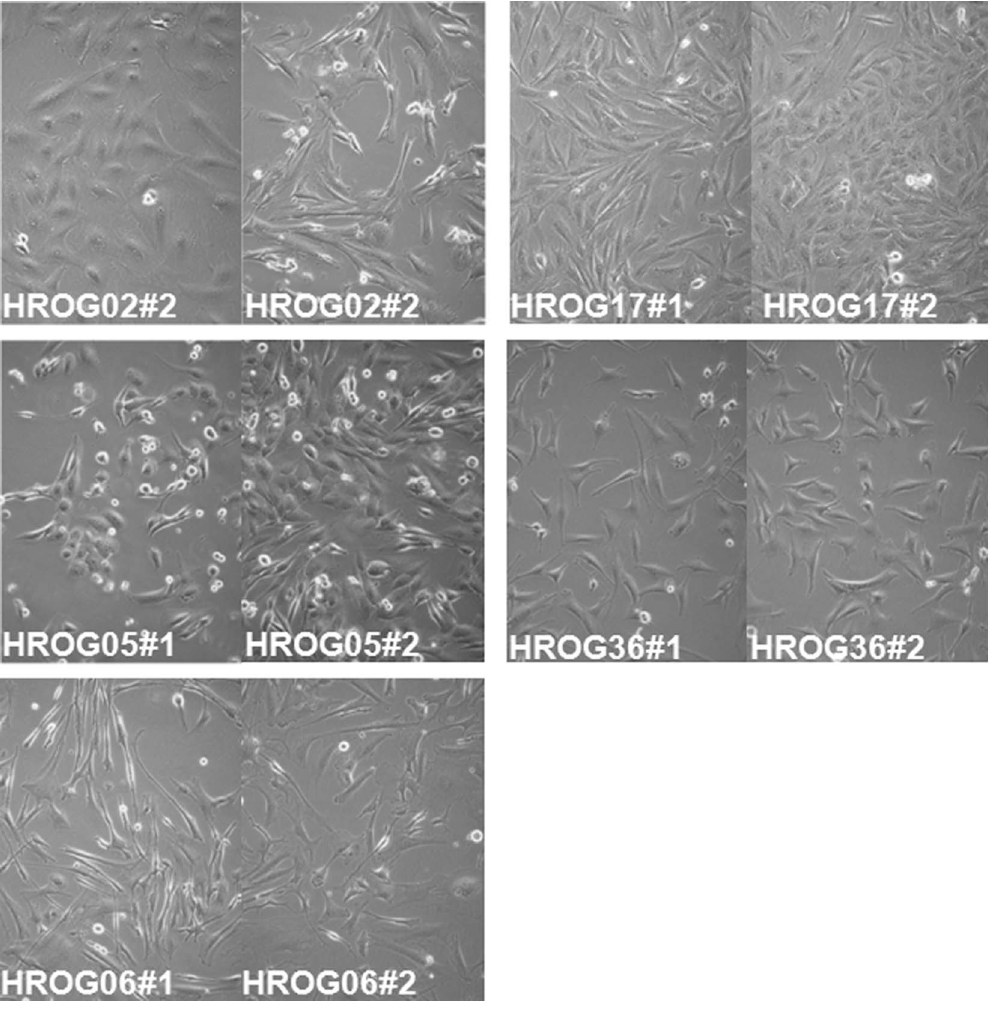
Figure 1. Cell line morphology. Phenotypes of the cell lines captured by microphotography are displayed pairwise. doi:10.1371/journal.pone.0071070.g001 PLOS ONE |